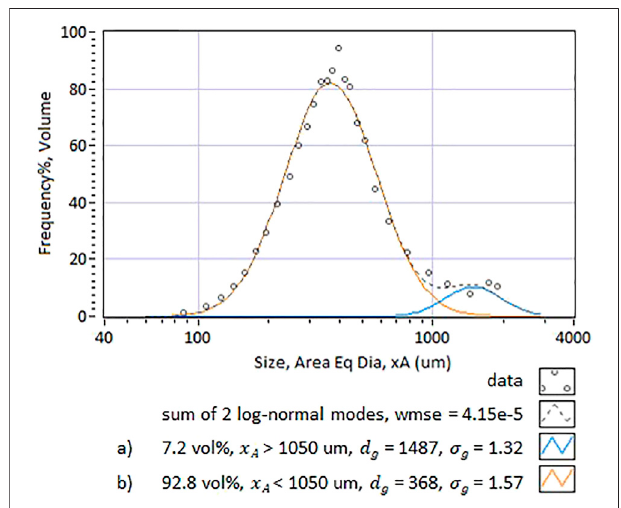
FIGURE 1 | Size distribution of fl y ash particles. The data points are overlaid with a fi tted curve determined by the sum of two log-normal